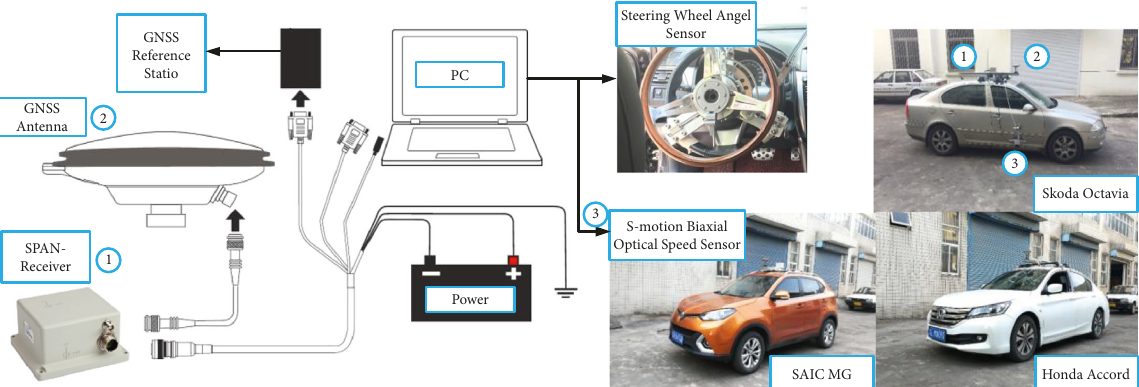
Figure 1: Test vehicles and equipment installation drawing.